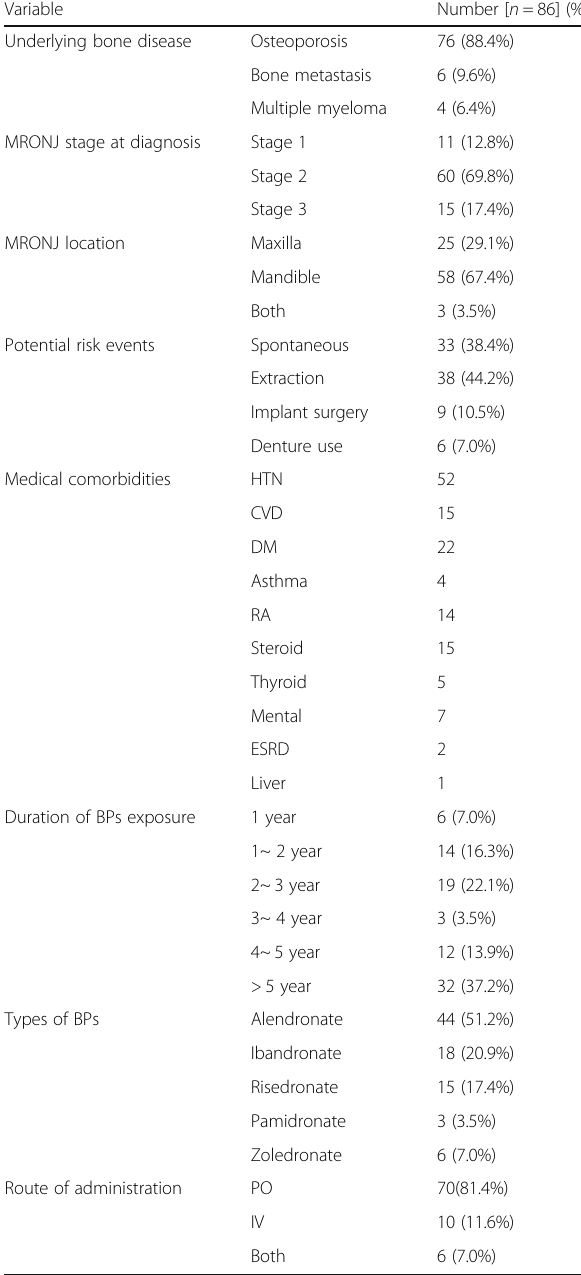
Table 1 Clinical characteristics of the patients who were diagnosed with